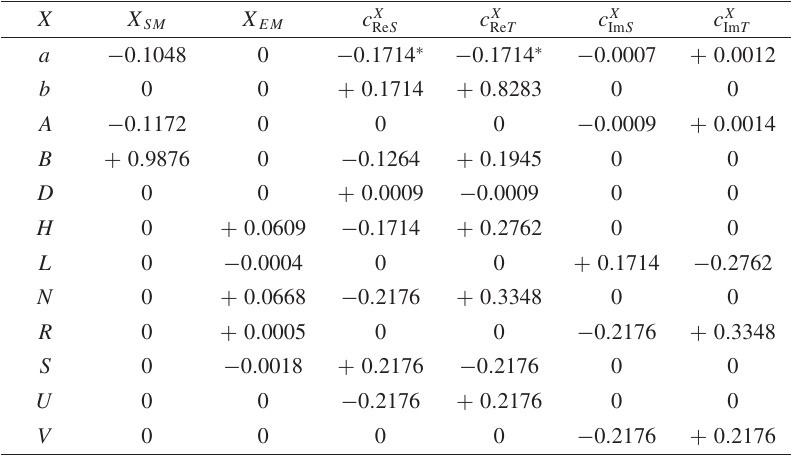
= (200 , 783)keV. This is an updated version of Table 2 k